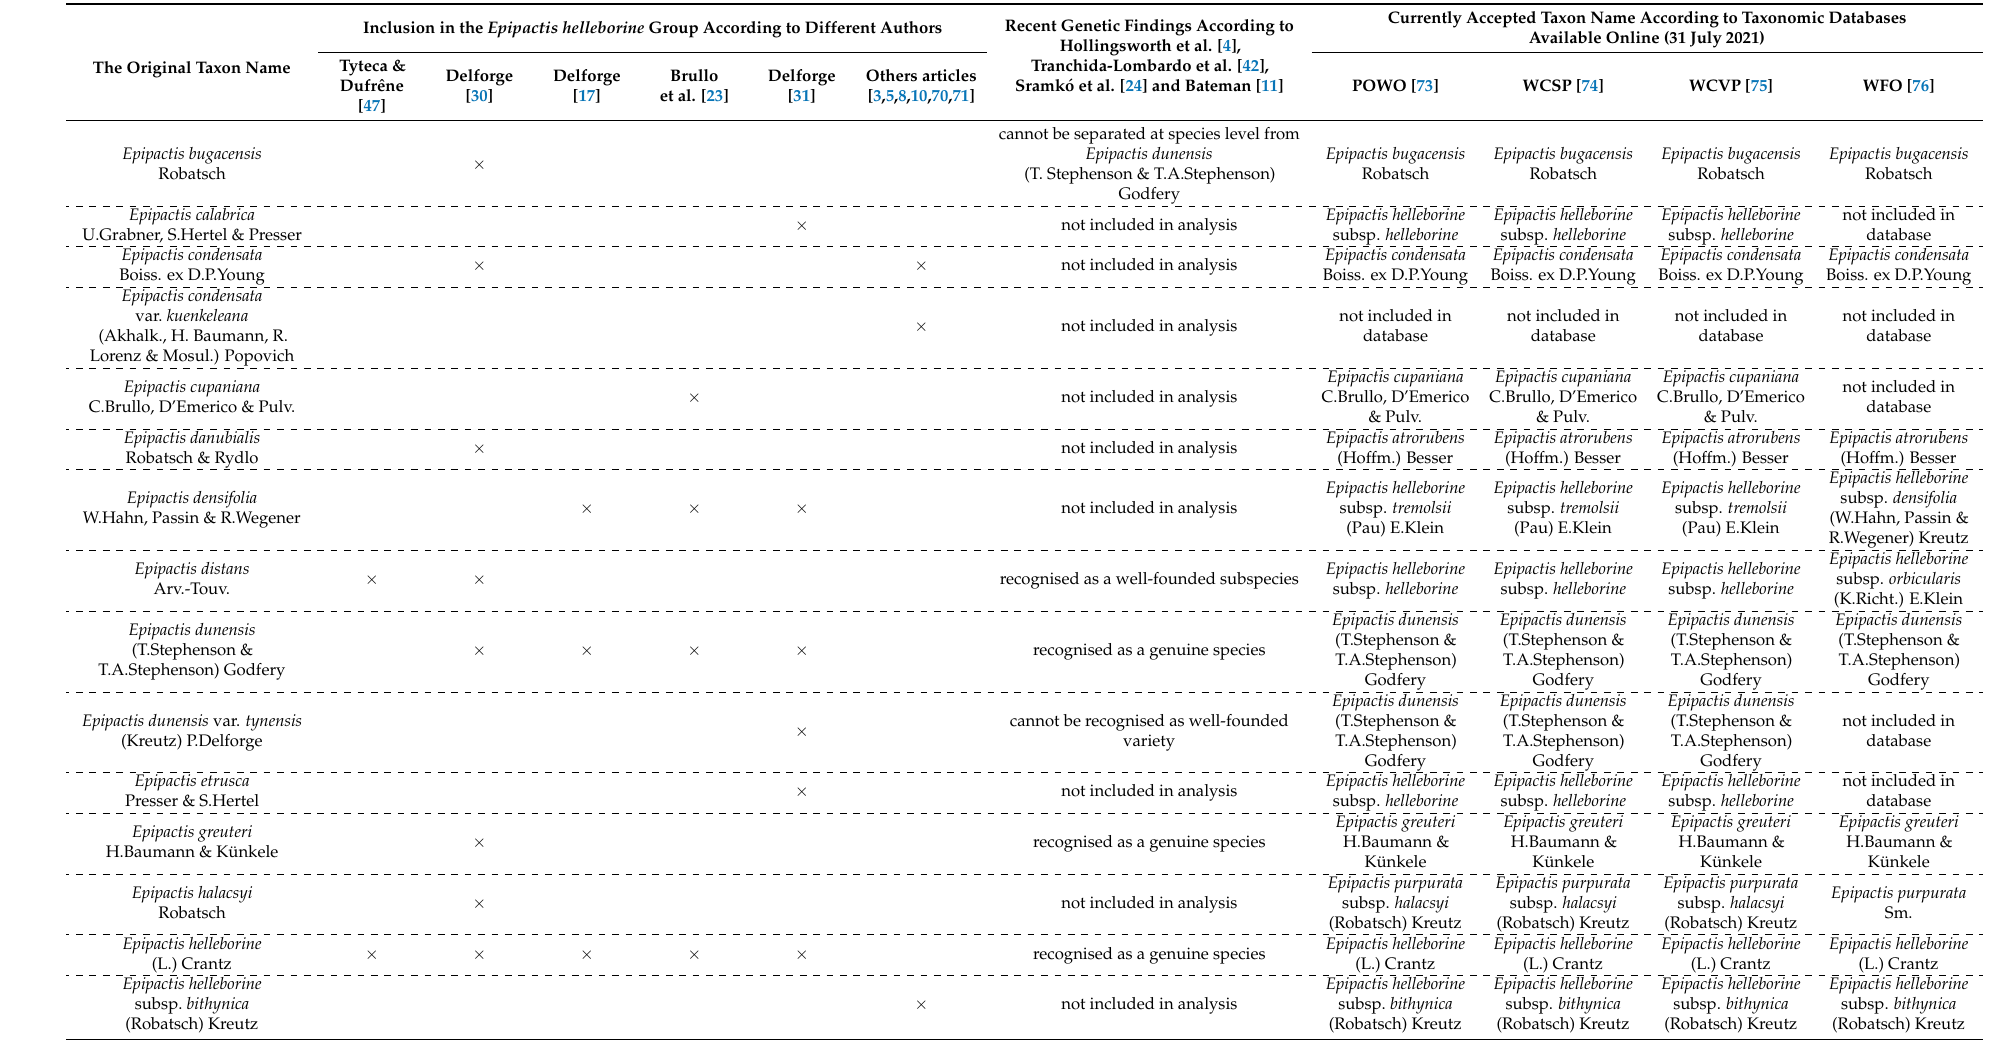
Table 1. Nomenclatural and taxonomic changes within the Epipactis helleborine